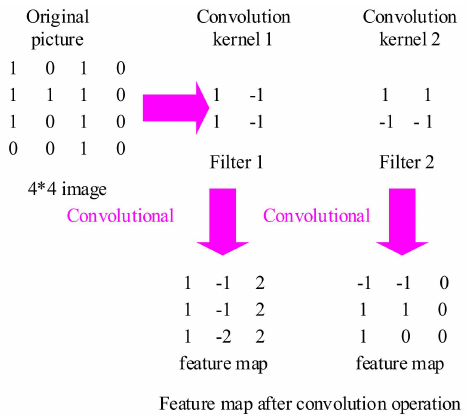
Figure 7. Image feature convolution process (Where 4*4 is the size of